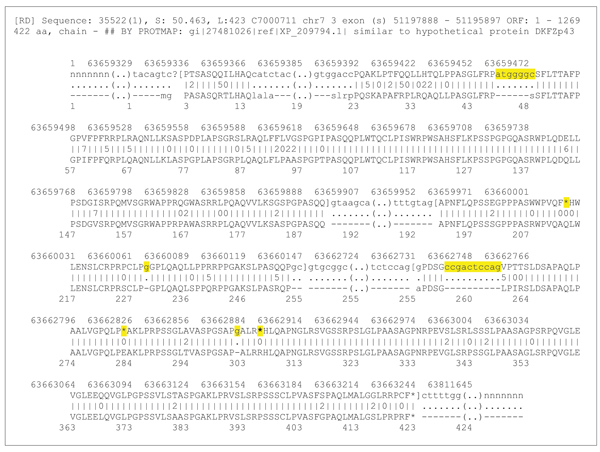
Example of a pseudogene that has not been processed. Alignment versus protein encoded by the parent gene. Identity, 86.4%; coverage of protein sequence, 97.6%; number of internal stop codons, 3; number of frameshifts, 4; Ka/Ks, 0.594.